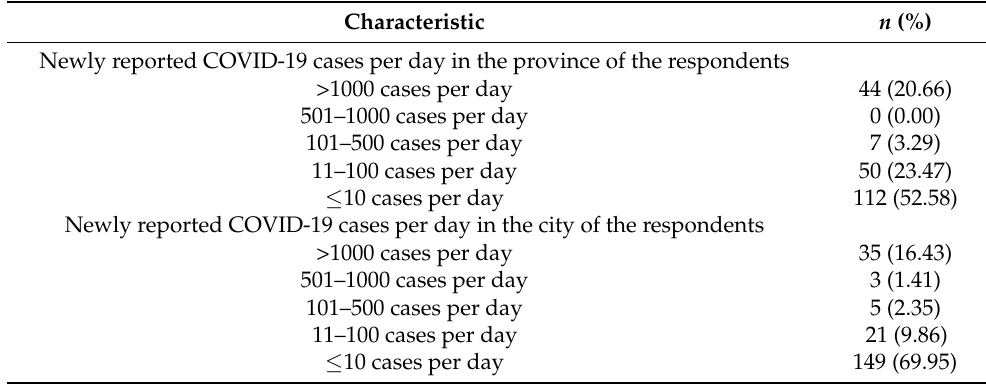
Table 2. The severity of COVID-19 pandemic at the locations of the participants ( n = 213).